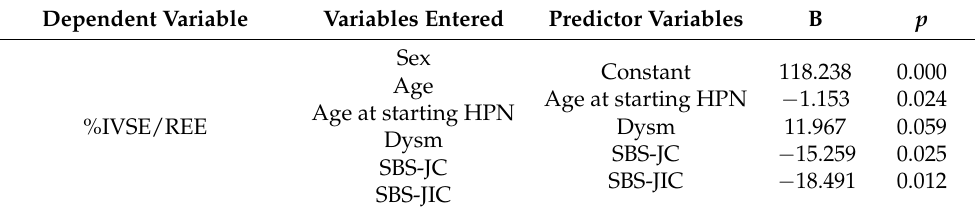
Table 3. Multivariate analysis of factors associated with the IVS energy dependency (%IVSE/REE). Dependent